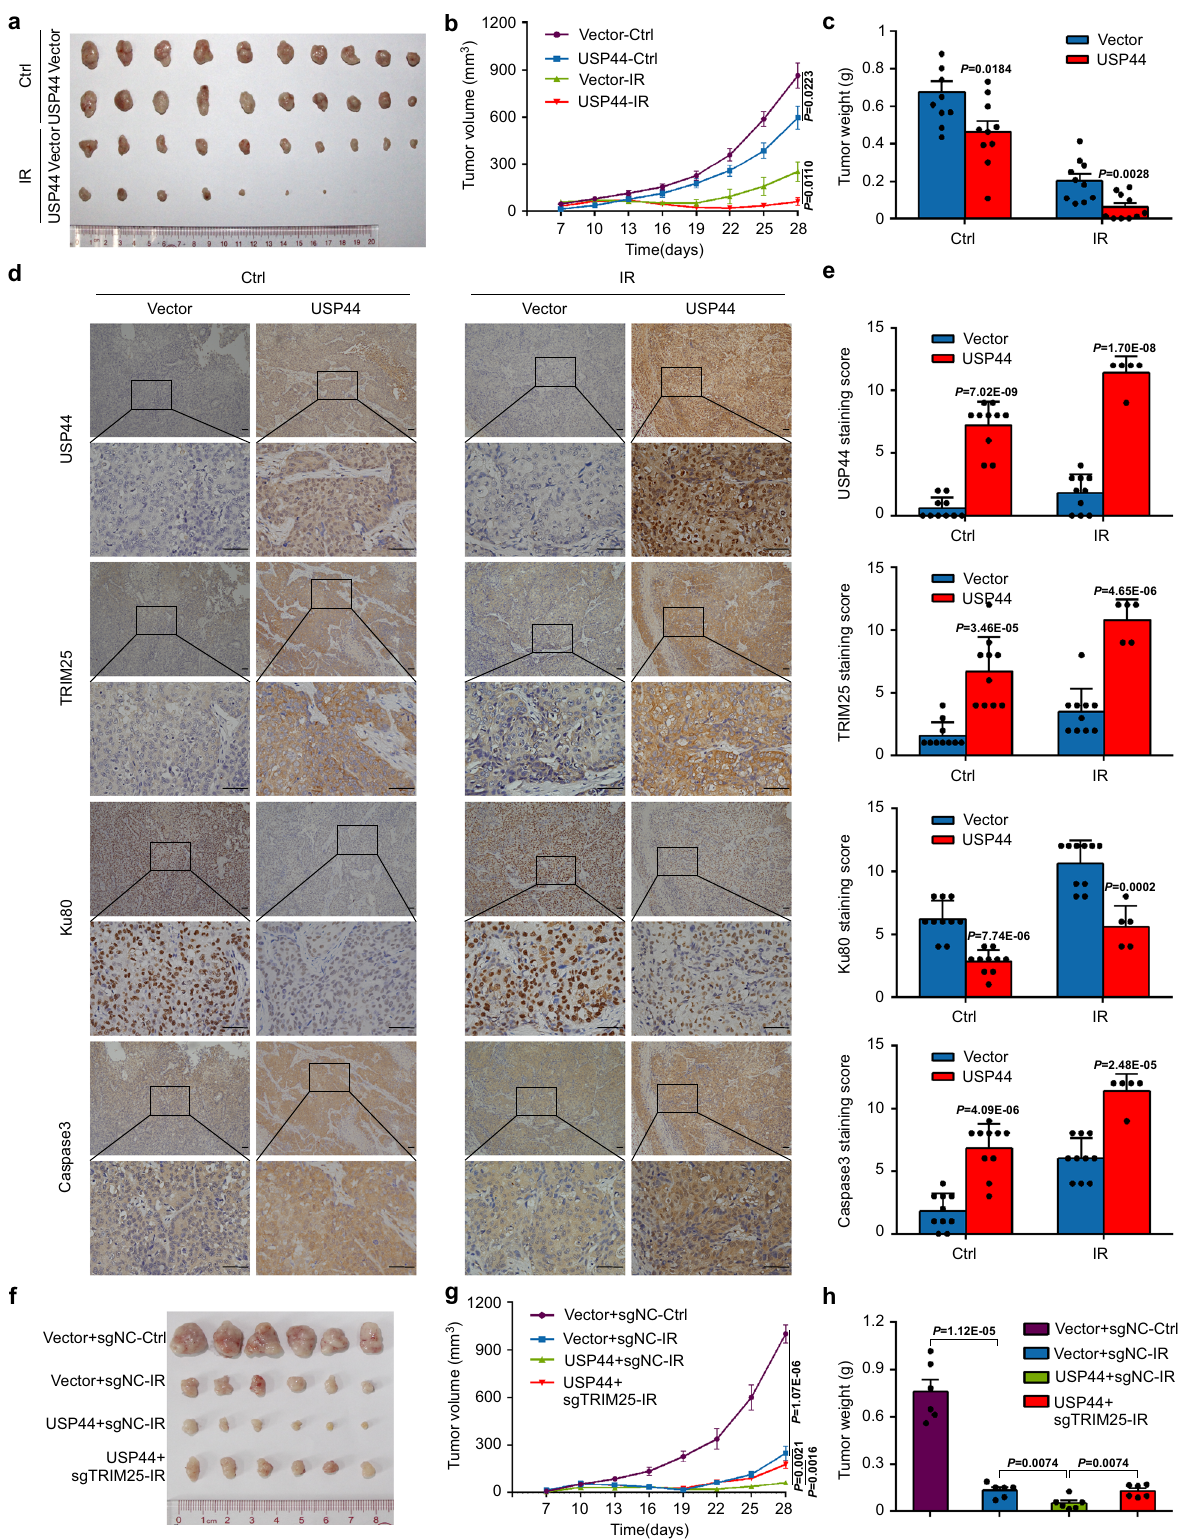
Fig. 7 USP44 promotes the radiosensitivity of NPC cells in vivo. The SUNE1 cells stably transfected with indicated plasmids were implanted subcutaneously into female BALB/c nude mice to construct xenograft growth models and exposed to 8Gy IR or not. a – c Macroscopic images ( a ), average volume ( b ) and average weight ( c ) of the excised tumours for each group ( n = 10). d , e Representative images of immunohistochemical staining and IHC scores for USP44, TRIM25, Ku80 and caspase 3 expression in the excised tumours from each group ( n = 5 for IR + USP44 group and n = 10 for the other three groups). Scale bars, 50 μ m. f – h Macroscopic images ( f ), average volume ( g ) and average weight ( h ) of the excised tumours for each group ( n = 6). Data in b , c , g , h are presented as the mean±SEM, and those in e are presented as the mean±SD; the P values were determined using the two-tailed Student ’ s t -test. Source data are provided as a Source Data fi